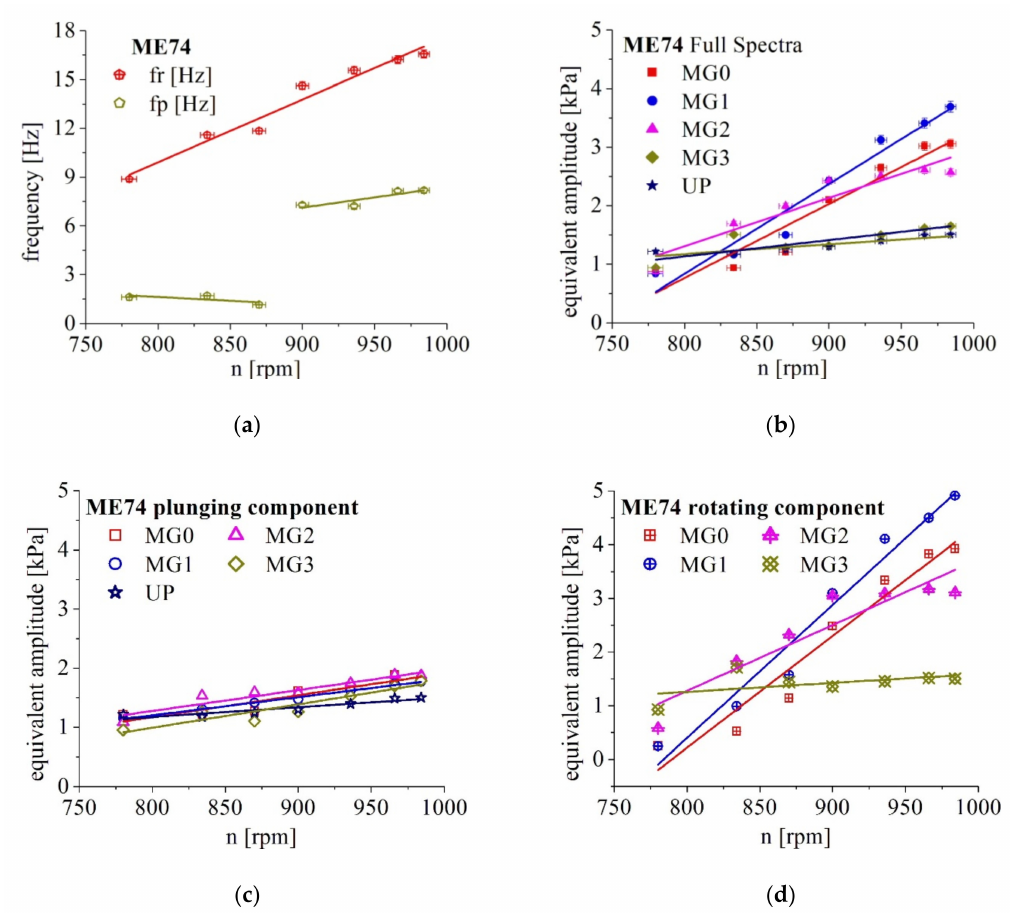
Figure 7. ( a ) Both fundamental frequencies corresponding to the rotating and plunging component generated in swirling flow with ME74 draft tube versus the rotor speed; ( b ) The equivalent amplitude of the pressure pulsation power spectra on all level versus the rotor speed; ( c ) The equivalent amplitude of the plunging pressure pulsation on all levels versus the rotor speed; ( d ) The equivalent amplitude of the rotating pressure pulsation on MG0, MG1, MG2 and MG3 levels versus the rotor speed. Linear regressions of experimental data are marked with solid lines to underline the trends with rotor